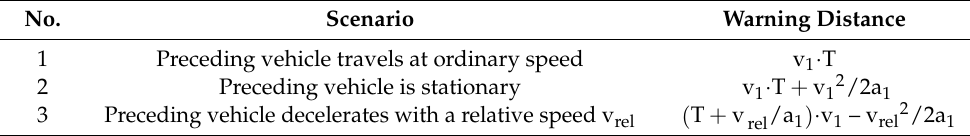
Table 3. Scenarios in FVCWS according to ISO 15623